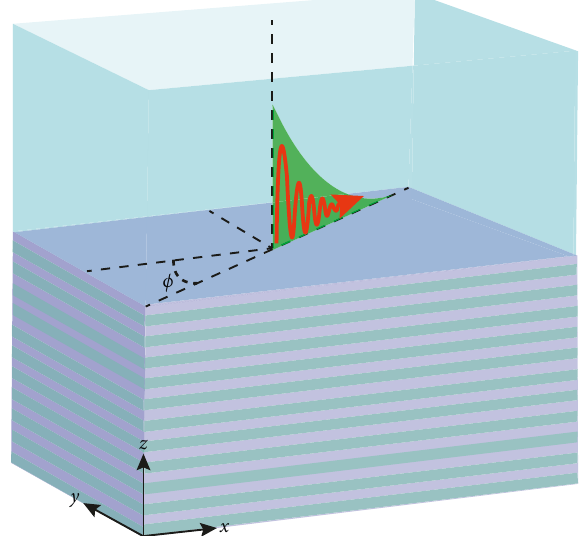
Figure 1: A multilayered model representing the simplest ap- proximation of wave propagation.